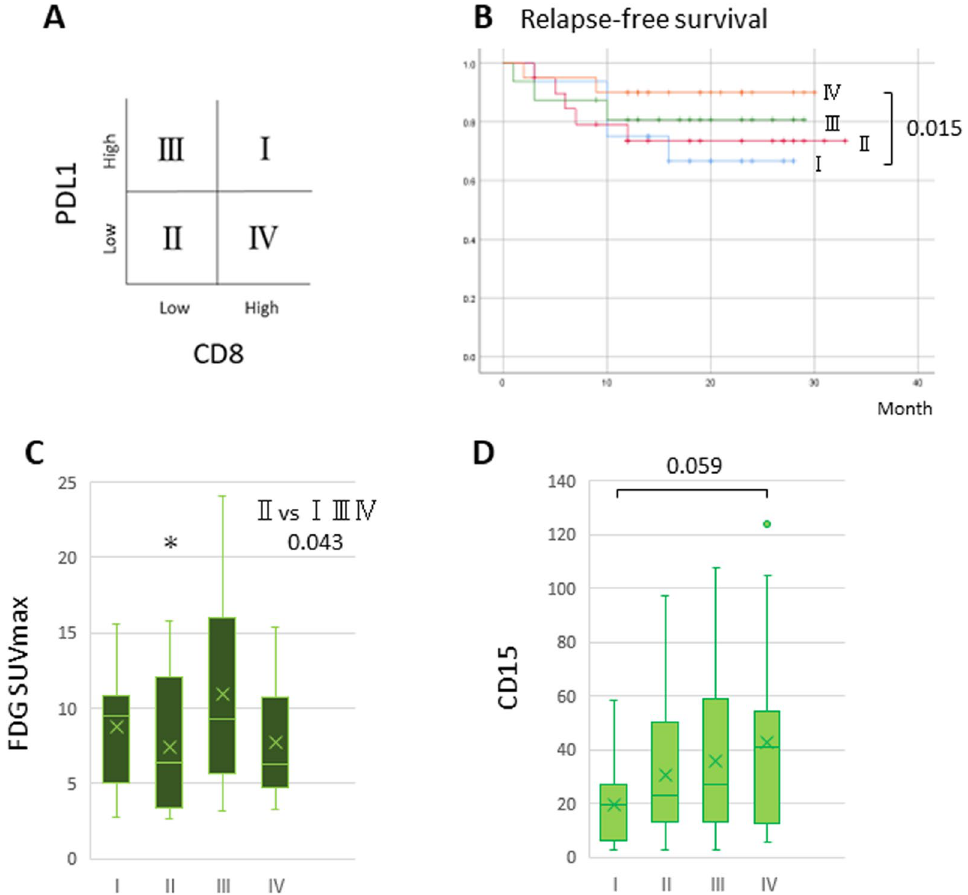
Fig. 2 A Patients were classified into four groups (I–IV) based on programmed death ligand-1 (PD-L1) expression in tumor cells and CD8 + cell counts at the tumor invasive front. B Kaplan–Meier plots of relapse-free survival in the subgroups. The differences in survival between groups I (high PD-L1 expression and high density of CD8 + cells) and IV (low PD-L1 expression and high density of CD8 + cells) were statistically significant ( P 0.015). C Box-and-whisker diagrams present fluoro- d -glucose (FDG) uptake in the four subgroups. Group II (low PD-L1 expression and low = density of CD8 + cells) had significantly lower FDG uptake (indicated by the maximum standardized uptake value (SUVmax)] than the other groups ( P 0.043). D The density of CD15 + cells at the tumor invasive front was not significantly different among the four groups, but comparing groups = I and IV, both of which had high CD8 + cell counts despite having high and low PD-L1 expression, respectively, group IV tended to have a higher density of CD15 + cells than group I ( D